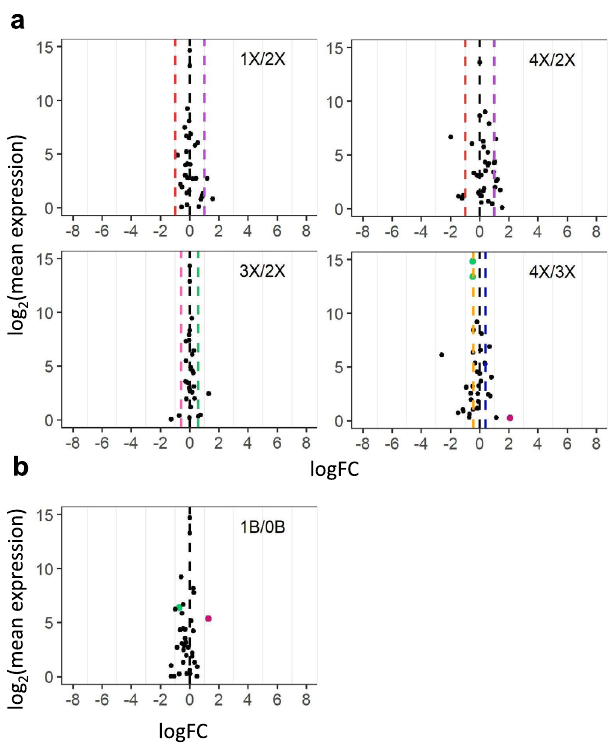
Fig. 7 Scatter plots of MIRNA expression in each ploidy series and B chromosome series. a Scatter plots in each ploidy series compared with diploids. Analysis was conducted as described in Fig. 2. A FC of 1.0 (logFC of 0) represents no change. FCs of 0.5 (1X/2X), 1.33 (4X/3X), 1.5 (3X/2X), and 2.0 (4X/2X) represent a gene-dosage effect, whereas FCs of 2.0 (1X/ 2X), 0.75 (4X/3X), 0.67 (3X/2X), and 0.5 (4X/2X) represent the inverse ratio of MIRNA expression. These FC values are demarcated with labeled vertical lines in red (0.5), pink (0.67), orange (0.75), black (1.0), blue (1.33), green (1.5), and purple (2.0). b Scatter plots of diploids with one B chromosome compared with the corresponding control with no B (1B/0B). Source data are provided in Supplementary Data 4. (Cluster_165899) located on 4L shows a positive dosage effect with the varied dosage of 1S but shows an inverse effect with altered copy number of the chromosomal segment 3S (Fig. 9b, f).